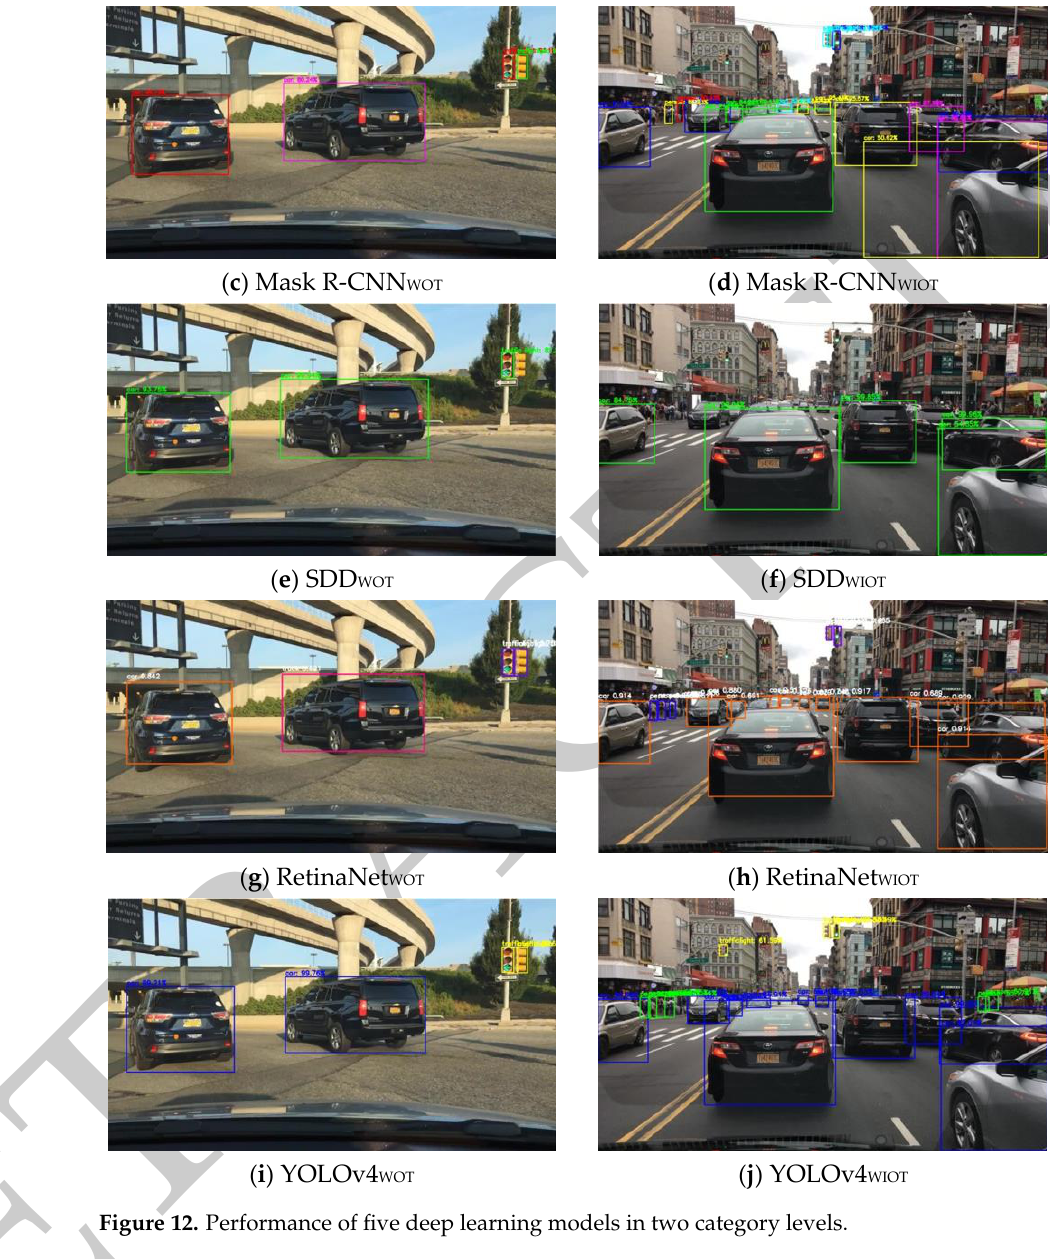
Figure 12. Performance of five deep learning models in two category levels.